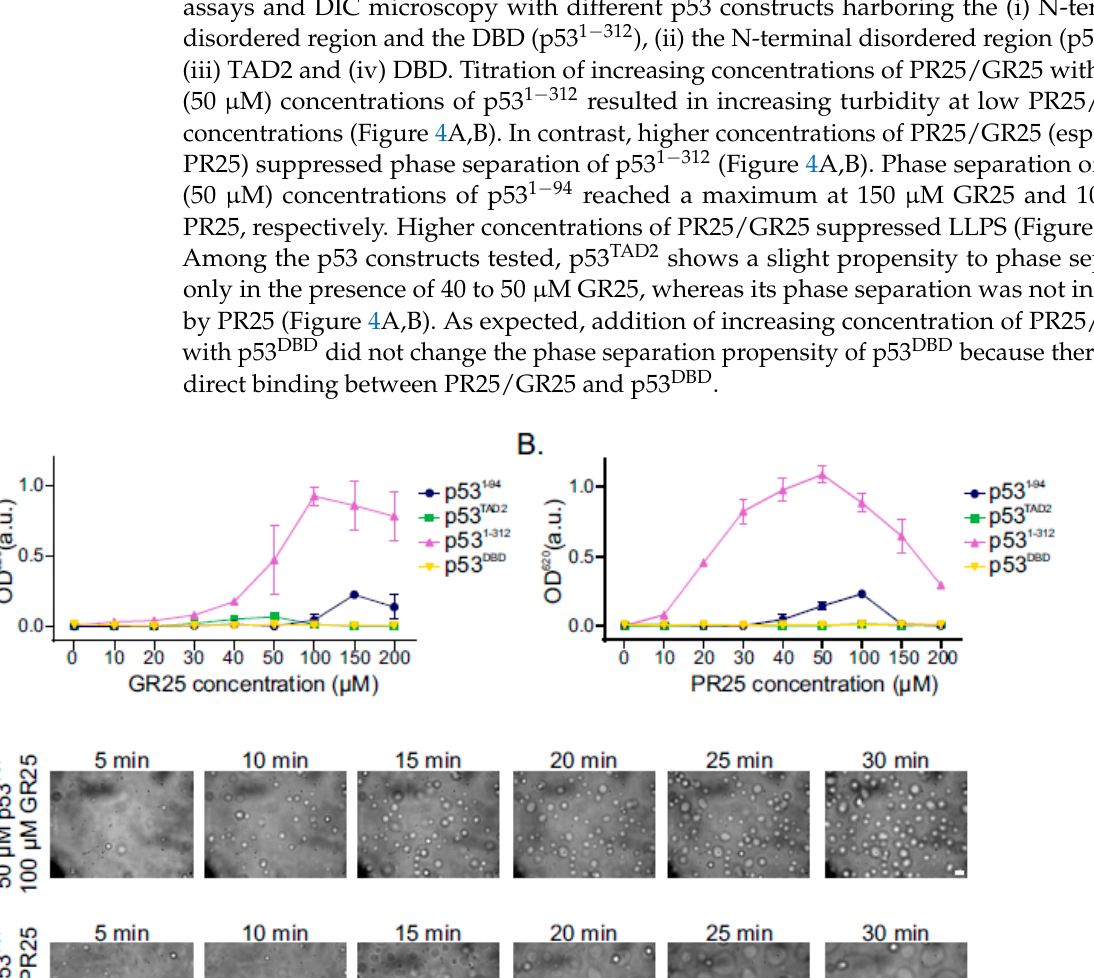
Figure 4. PR25/GR25 modulate LLPS of p53 . ( A , B ) Turbidity assays to quantify phase separation of p53 domains with fixed p53 concentrations (50 µM) and increasing either GR25 concentration in ( A ) or PR25 concentration in ( B ). Values represented mean ± SD (n = 3); ( C ) DIC microscopy images of p53 1 − 94 at 50 µM in the presence of either 100 µM GR25 (upper panel) or 100 µM PR25 (bottom panel);